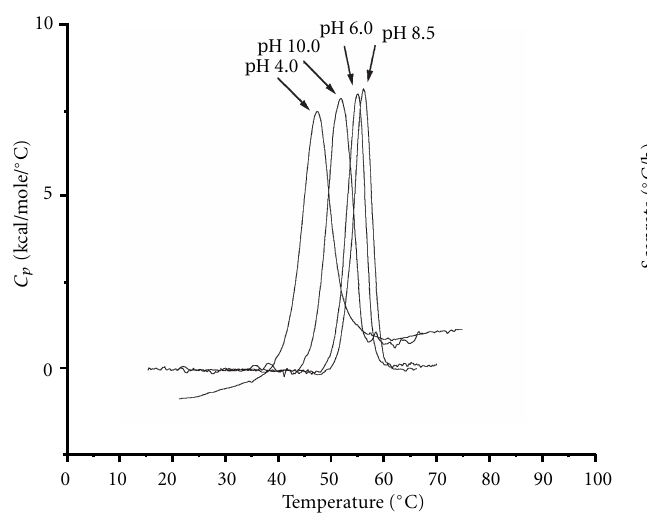
Figure 1: Original DSC scans of native cutinase at different pH val- ues. The protein concentrations were 0 . 7 mg/ml for all experiments. The thermograms were all baseline corrected. The buffers were cho- sen as described in materials and methods.